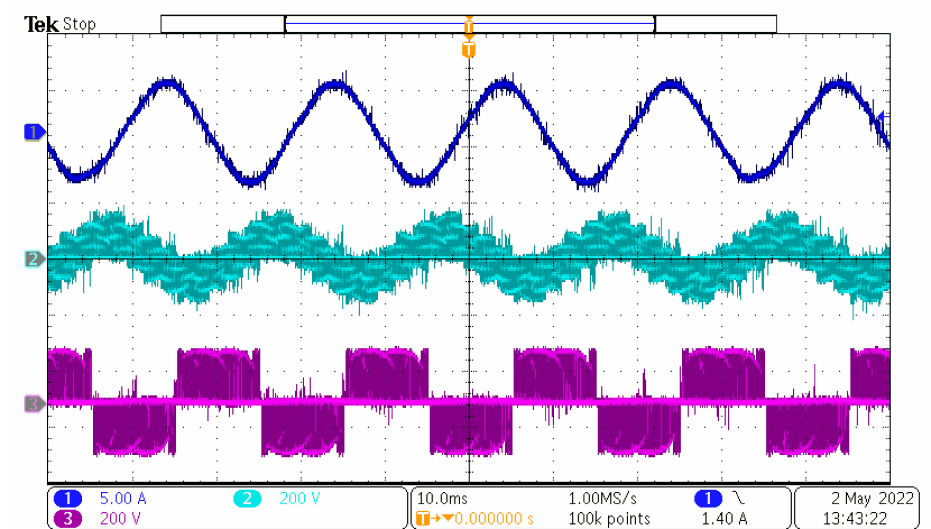
Figure 12. Measured results at f IN = 50 Hz and f OUT = 50 Hz. CH1—output current, CH2—output load voltage, CH3—output phase to phase